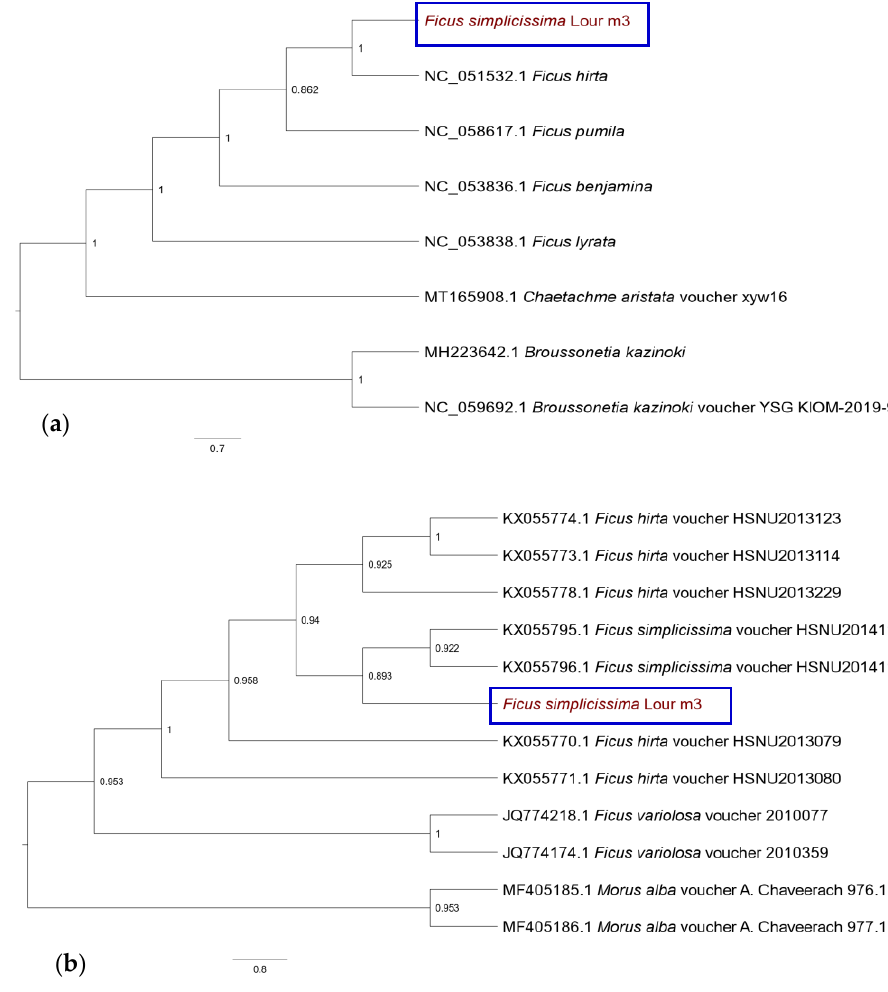
Figure 4. Phylogenetic relationships among Moraceae family based on complete cp genome ( a ) and psbA-trnH intergenic region ( b ).